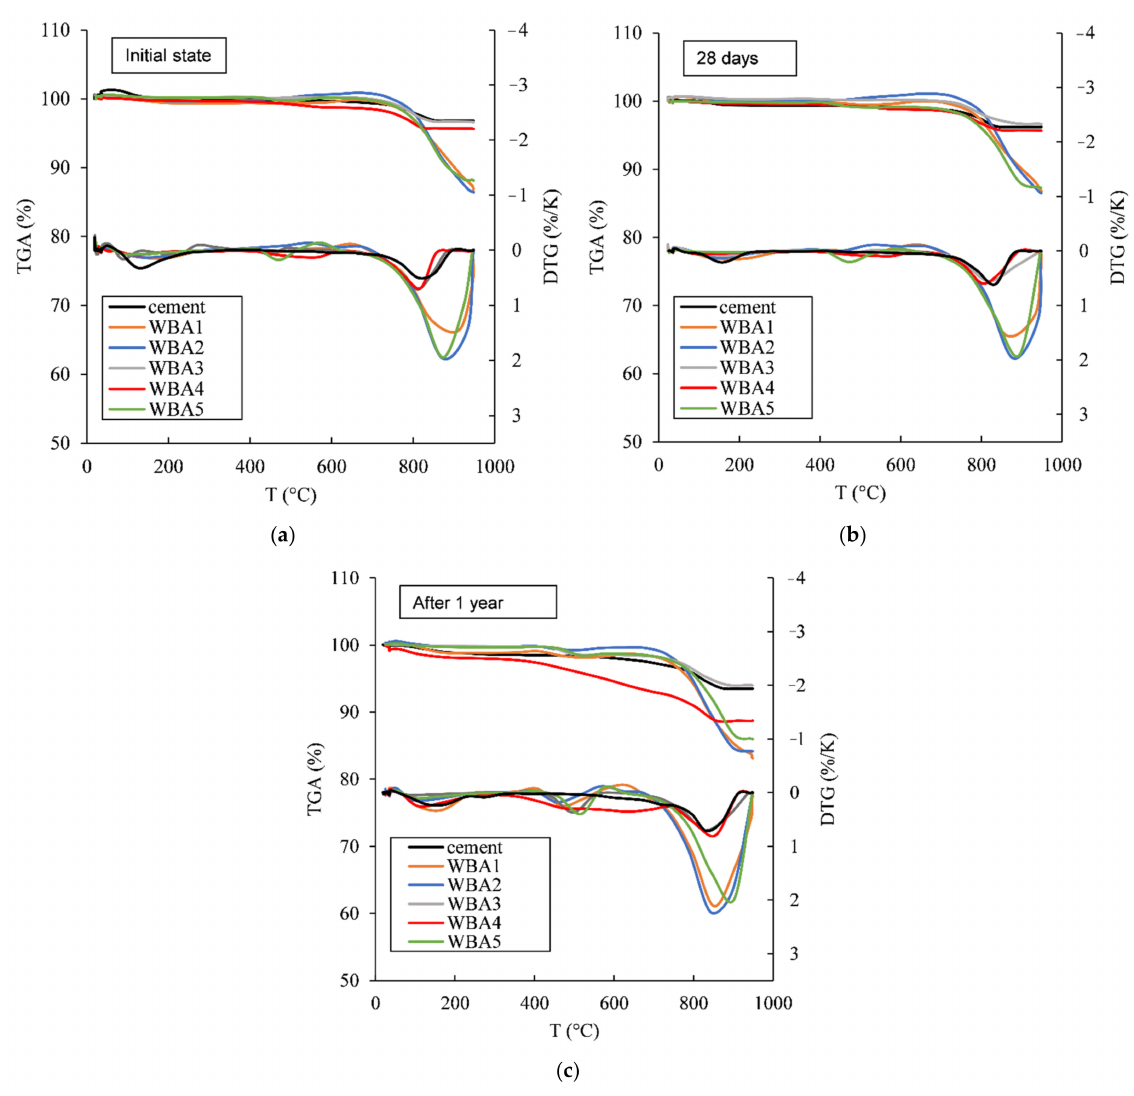
Figure 3. Thermogravimetric (TG) and differential thermogravimetry (DTG) curves of cement and wood biomass ash (WBA) samples for: ( a ) initial state; ( b ) 28 days, and ( c ) after 1 year (the data are available in Supplementary